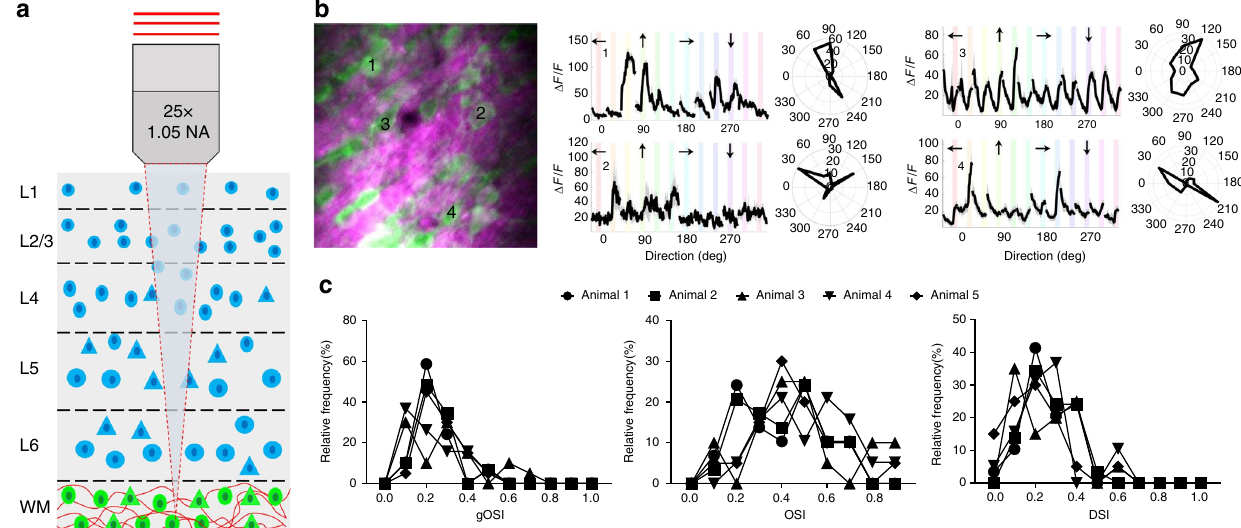
Fig. 5 Characterization of visual responses of subplate neurons in the white matter below V1 layer 6. a Schematic coronal section of V1 showing locations of cortical (blue) and subplate (green) neurons surrounded by bundles of myelinated axons (red). b Left: Three-photon image of subplate neurons (green) and myelinated axons (magenta) in the white matter. Scale bar, 50 µ m. Right: Average calcium responses ( Δ F / F ) for representative cells in response to oriented gratings drifting in speci fi c directions (arrows above each trace) and their orientation tuning curves in polar plots. Discontinuities in ( Δ F / F ) traces are due to the randomization of each stimulus direction in each trial. c Population responses of subplate neurons showing global OSI, local OSI, and DSI. Total numbers of subplate neurons imaged in each animal are 43, 48, 38, 35, and